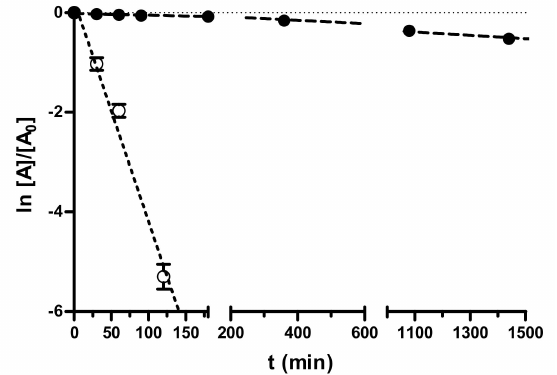
Figure 2. Pseudo-first-order kinetic plots of the decomposition of nafamostat in 0.05 M PBS (pH 7.4, 0.15 M KCl) and in pooled human serum at 37 ◦ C. Data points represent means ± SD of three independent measurements by RP-HPLC at various time points in 24 h